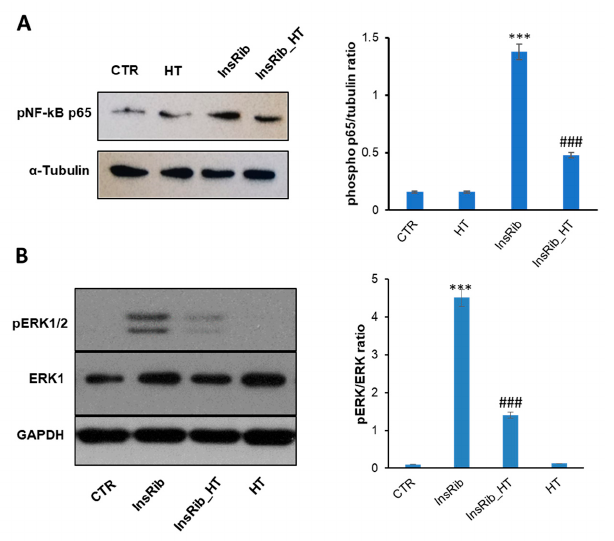
Figure 8. Effect of HT on NF-kB and Erk 1/2 activation. Western-blot analysis of phosphorylated p65 NF- 𝜅 B ( A ) and Erk 1/2 expression and phosphorylation ( B ) in SHSY5Y cells treated for 24 h with glycated insulin in the absence (InsRib) and in the presence of HT 1:1 molar ratio (InsRib_HT). CTR: untreated cells. HT: cells treated with only HT for 24 h. Working concentrations were 40 µ M both for insulin and HT. Other experimental conditions are described in the Methods section. *** p < 0.001 versus CTR, ### p < 0.001 versus